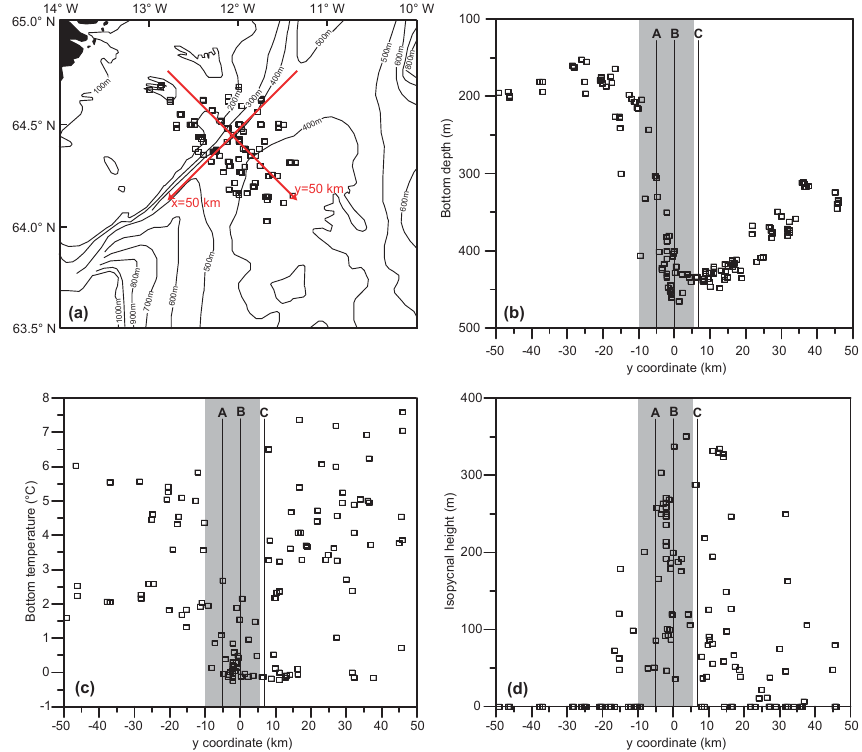
Figure 11. (a) Selected CTD stations in the sill region with coordinate system indicated by red arrows. (b) Variation along the y axis of bottom depth. (c) Variation along the y axis of bottom temperature for profiles with the CTD reaching less than 40m from the bottom. (d) Variation along the y axis of the height of the σ θ = 27 . 8kgm − 3 isopycnal above the bottom. Isopycnal height of 0 indicates that the whole water column was less dense than 27.8kgm − 3 . (b–d) The three mooring sites of the field experiment are marked by thin vertical lines. The origin of the y axis is located at site B, and the grey areas highlight the region from y = − 10km to y =